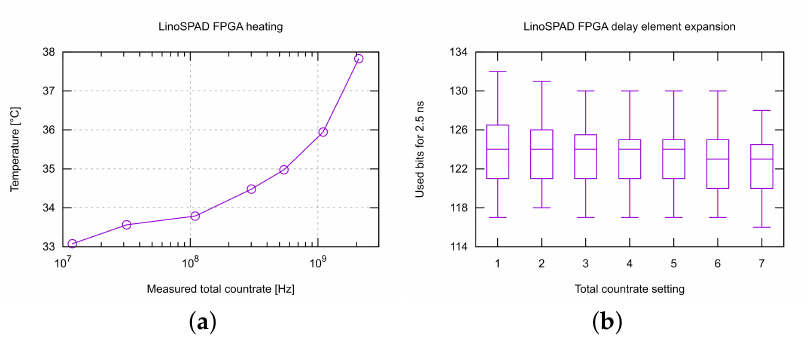
Figure 10. ( a ) Seven different illumination conditions for the sensor with their corresponding total count-rate and FPGA temperature; ( b ) Number of delay bits used under the same conditions for all the TDCs on the FPGA. We observe a decrease of used bits (longer delays) for higher temperatures.